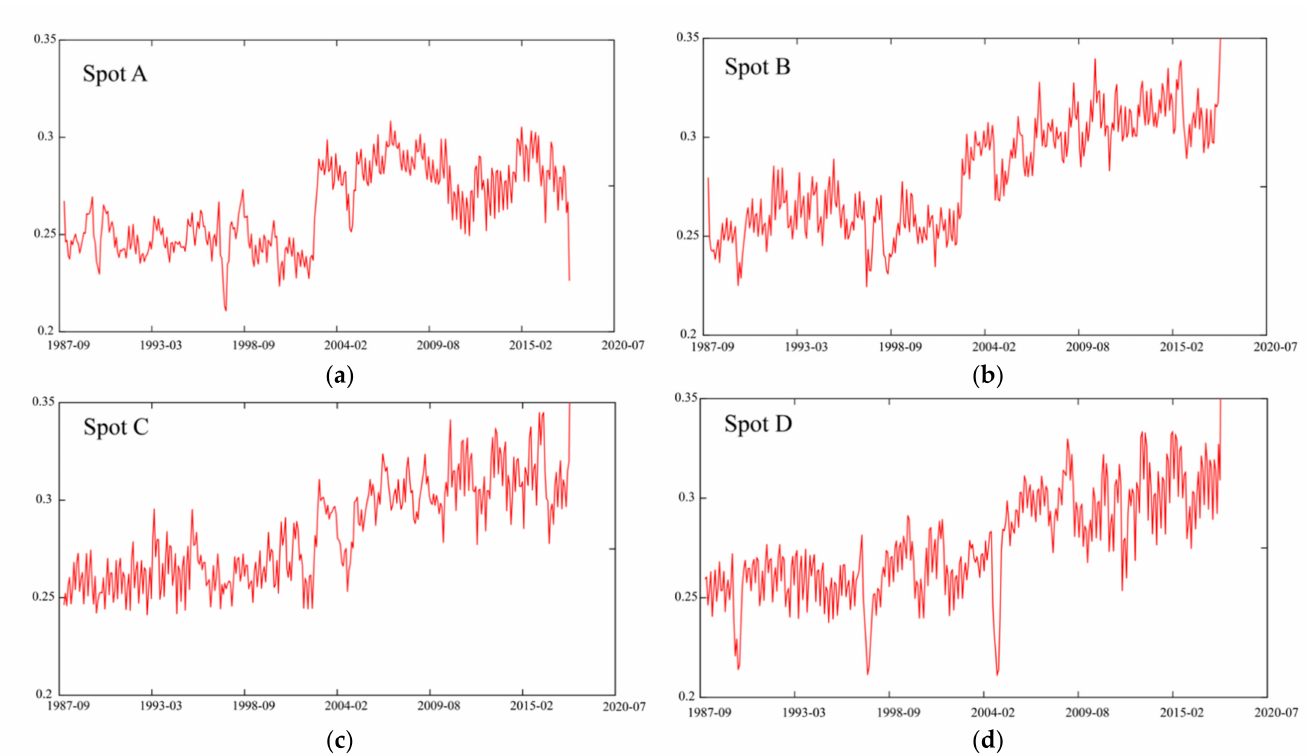
Figure 10. The time series of Stokes transport based on simulations from the WW3 model using CCMP wind data in 1989–2019 at four spots in Figure 3: ( a ) spot A; ( b ) spot B; ( c ) spot C; and ( d ) spot